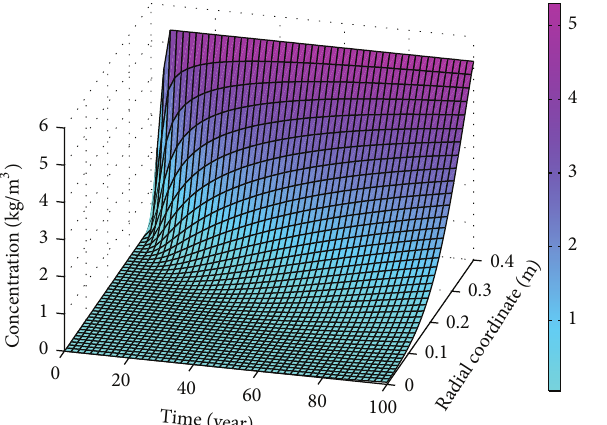
Figure 4: The evolution of chloride concentration inside a concrete column of radius 0 . 4 m. The chloride concentration at the outer surface increases linearly for the first five years of exposure and subsequently remains at the saturated level of 5.343 kg/m 3 [6]. 𝑤/𝑐 = 0 . 4.